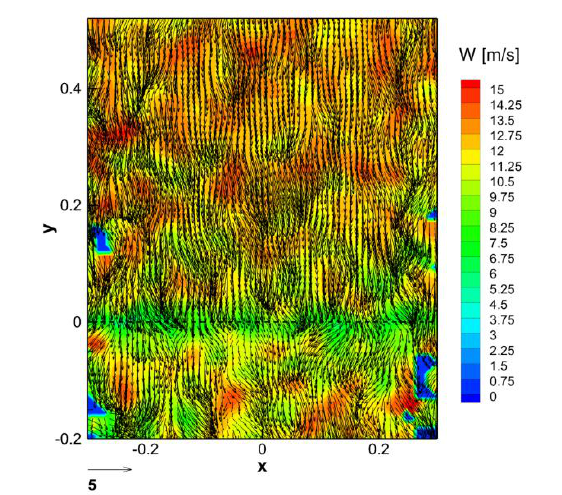
Fig. 2. Example of the instantaneous velocity field. Re = 0.5M.